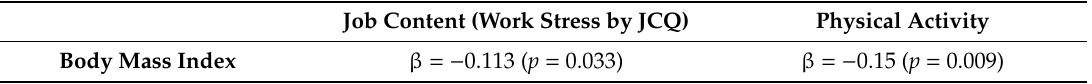
Table 7. Model 3. Direct e ff ects of the relationships between work stress, physical activity, and BMI.